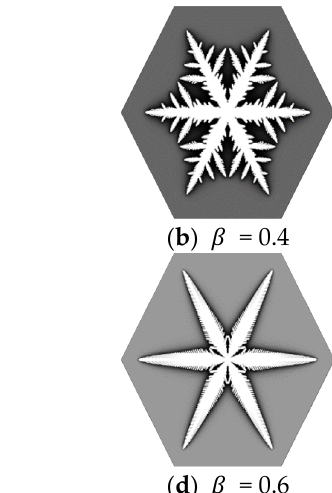
Figure 6. Snowflake simulation of the CA model.